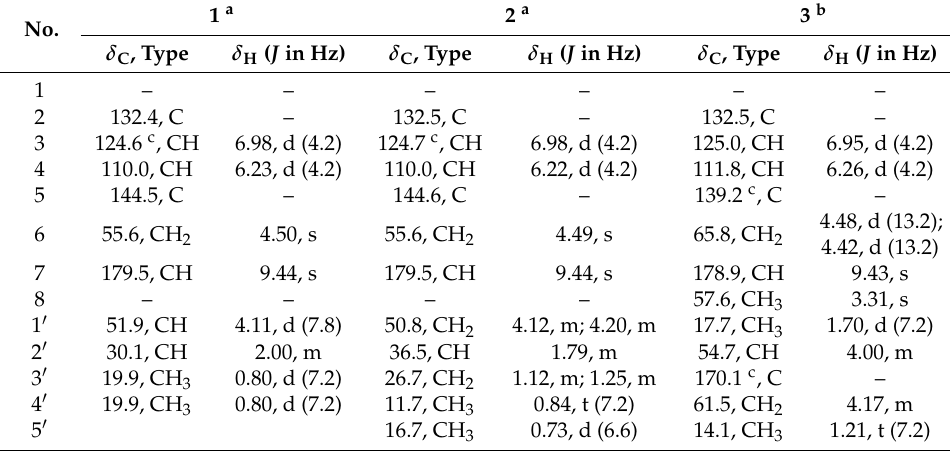
Table 1. NMR spectral data of 1 – 3 (600 MHz for 1 H-NMR and 150 MHz for 13 C-NMR).